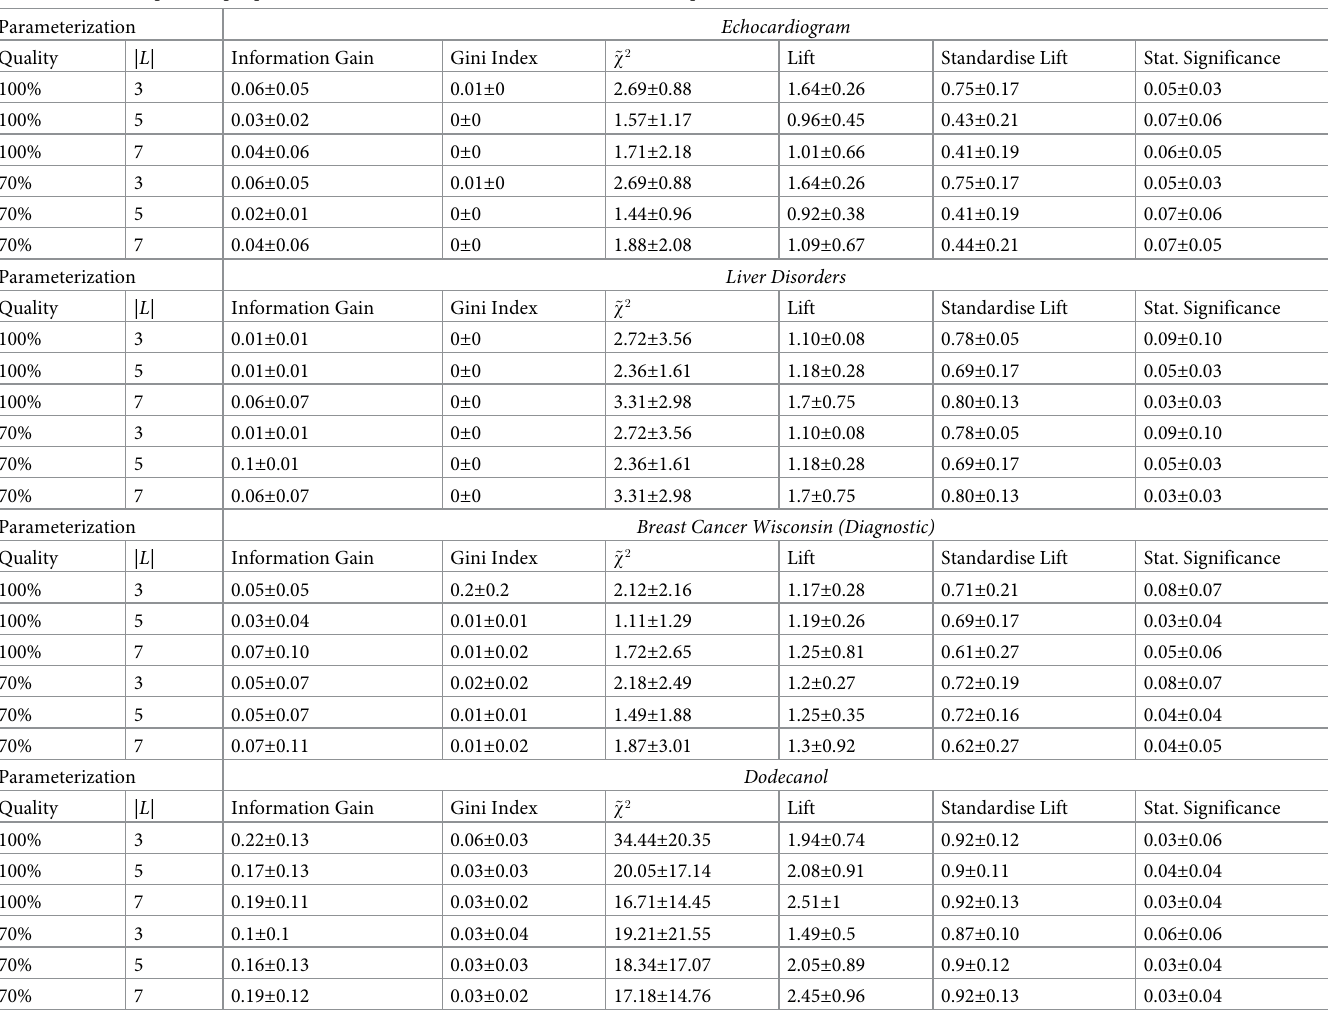
Table 4. Results of the analysis of DISA (gaussian) across all patterns per dataset. A selective list of statistical measures is provided. For each measure, the average value obtained across the patterns per parameterization, as well as the standard deviation, are